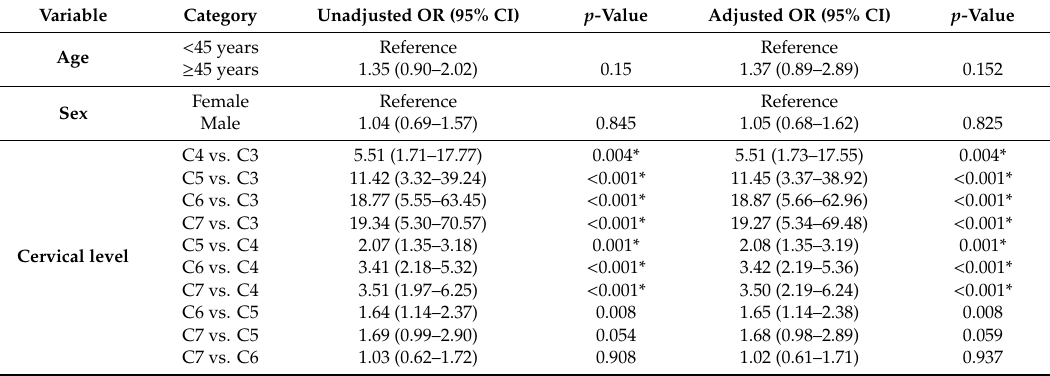
Table 3. Univariate and multivariate logistic regression analyses of extra-cervical facet joint flow occurrence comparing pairwise cervical